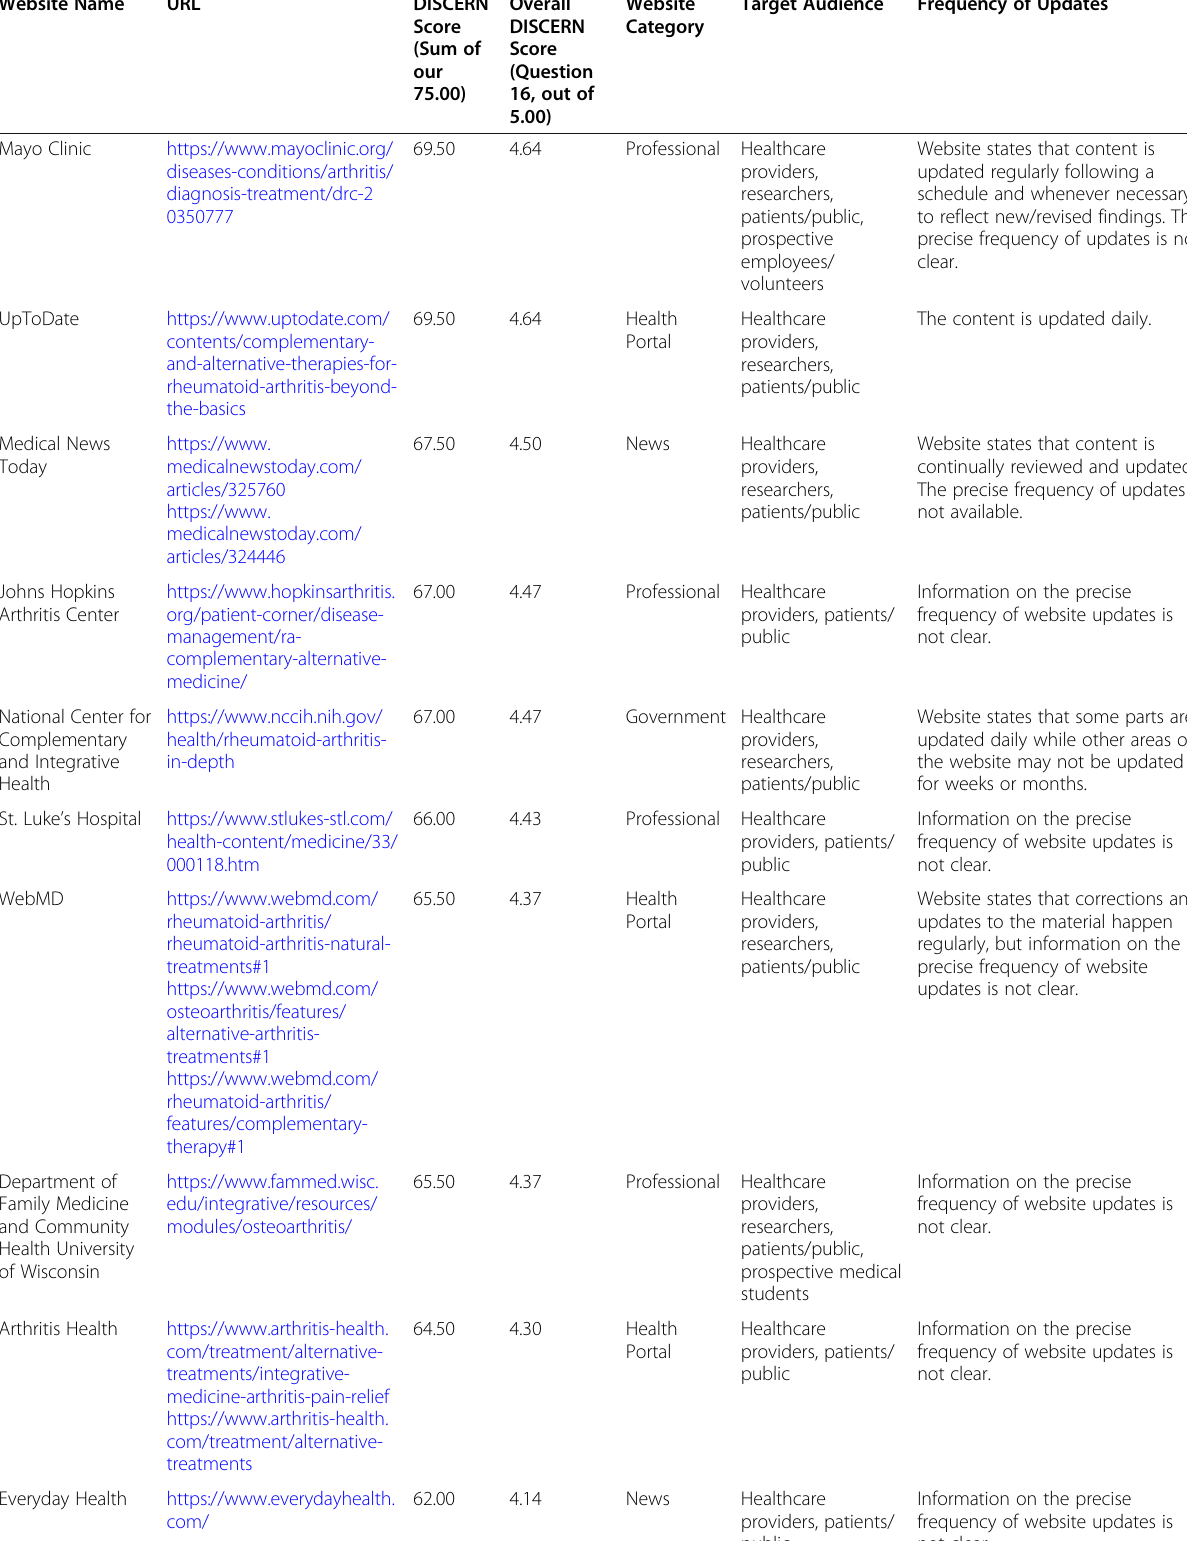
Table 3 Recommended Websites for Patients and